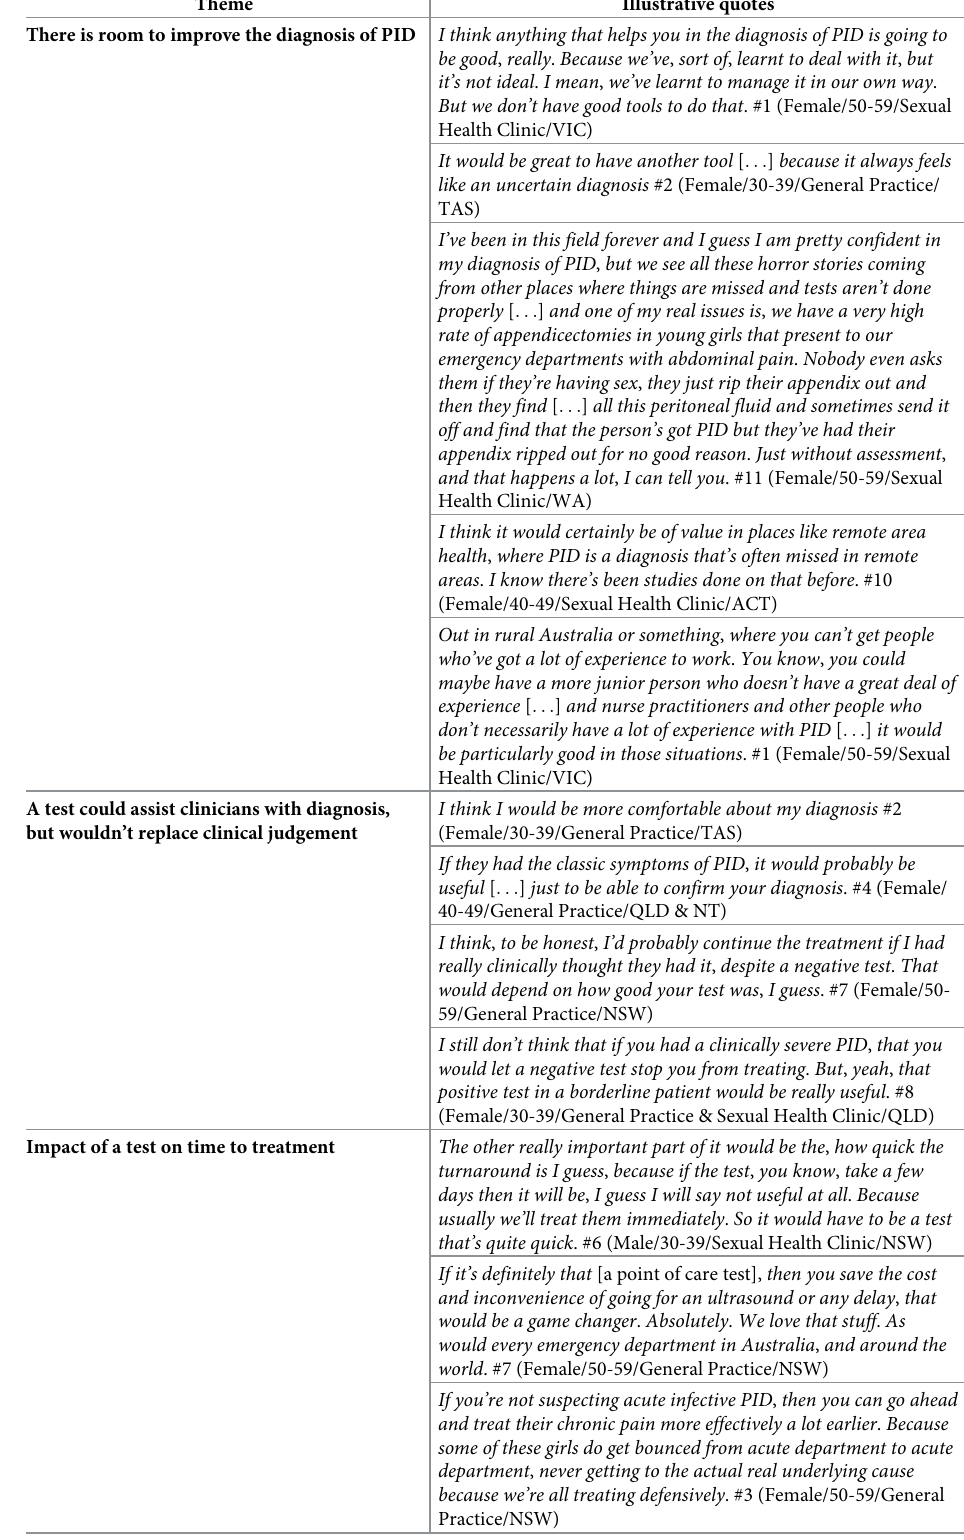
Table 2. Themes and illustrative quotes from interviews with